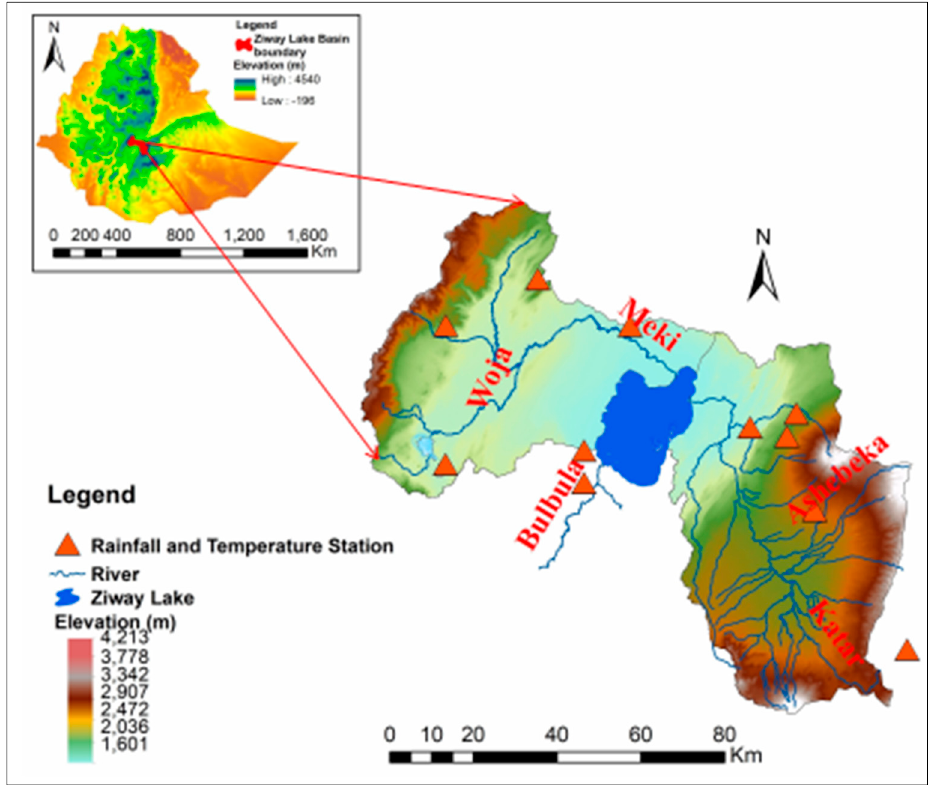
Figure 1. Topographic map of the Ziway Lake Basin.